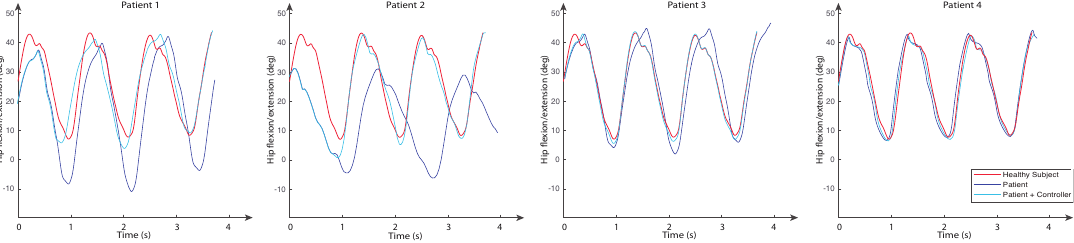
Figure 12. Hip flexion/extension angles for a normal subject (reference signal) and four subjects with multiple sclerosis for both open loop and using the PD adaptive